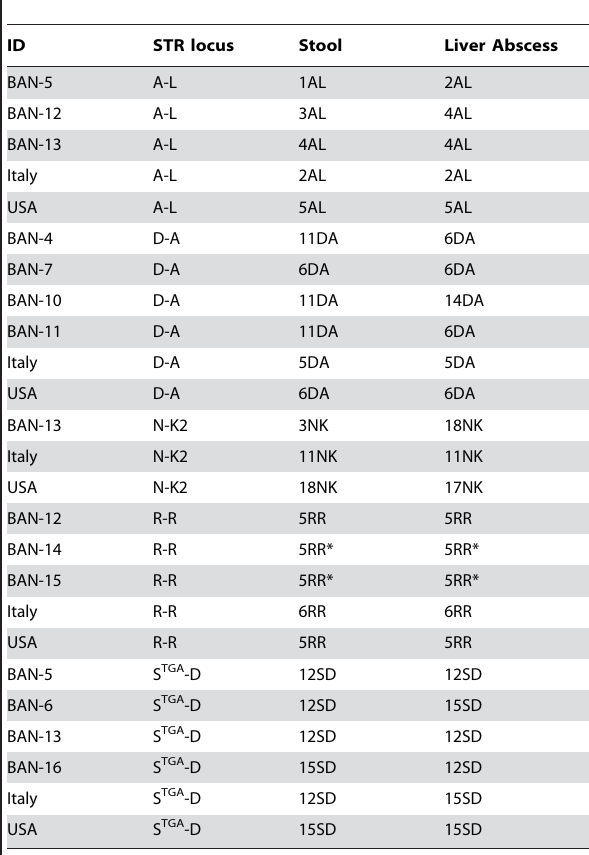
Table 2. Comparison between sequence types in liver abscess versus stool DNA from ALA patients.